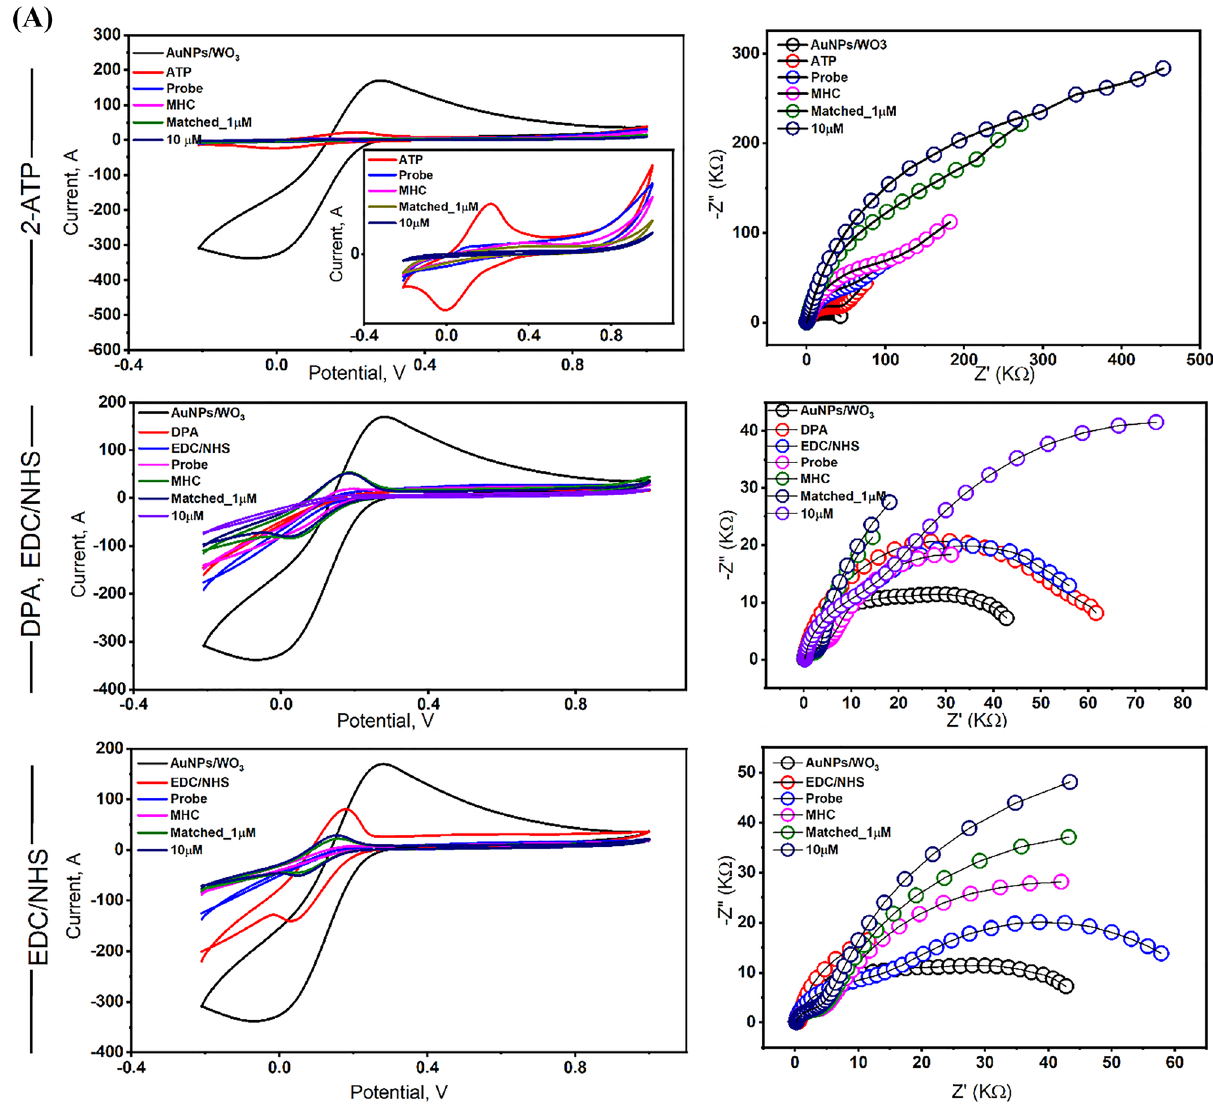
Figure 2. ( A ) Using different crosslinking agents including 4-ATP, EDC/NHS, and DPA/EDC/NHS. The voltammetric and the impedimetric signals were investigated in FCN/TE. Modified surfaces with the 4 - ATP showed the highest significant response. ( B ) The 4-ATP -based electrode showed a remarkably decrease in the voltammetric signals after the hybridization with the matched oligonucleotides (I). Significant impedimetric signals were obtained for the hybridized attached probe